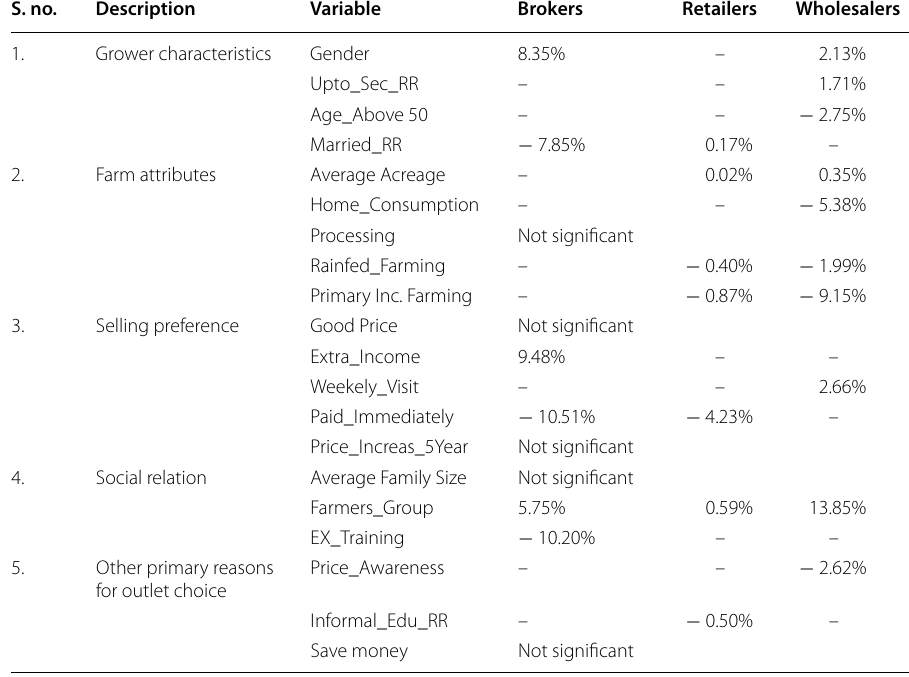
Table 3 Marginal effects of multinomial logit estimation of AIV outlets S.